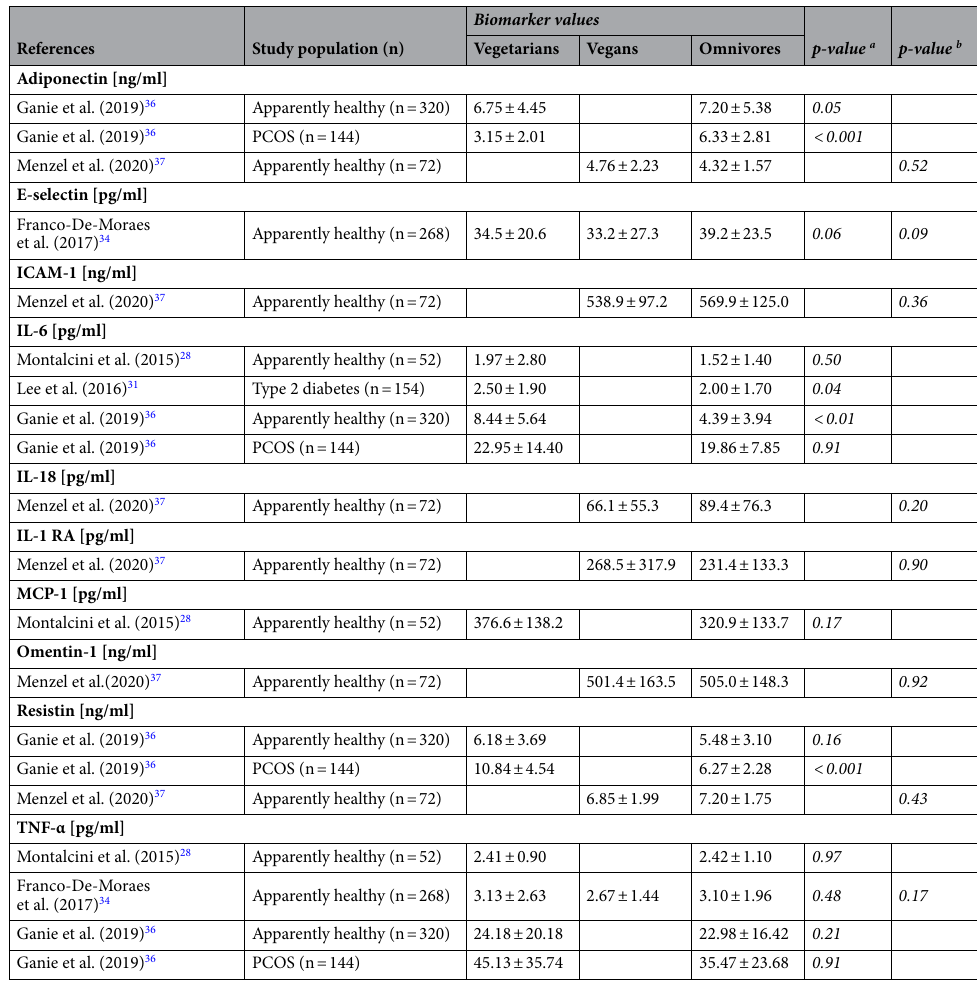
Table 2. Summary of the concentrations of inflammatory biomarkers in vegetarians, vegan in comparison control group. a Vegetarian versus omnivore; b Vegan versus omnivore; Values expressed as mean ± SD.